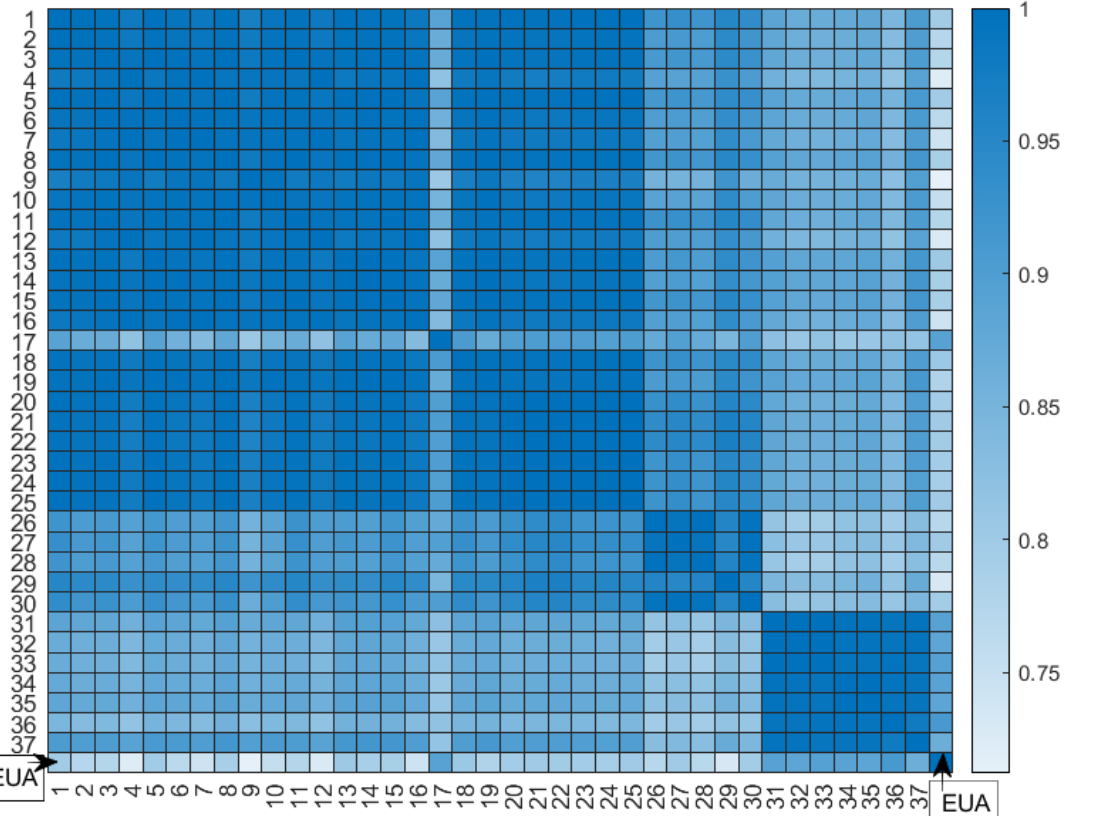
Figure 4. Visualize summary statistics with box plot for all analyzed indicators.